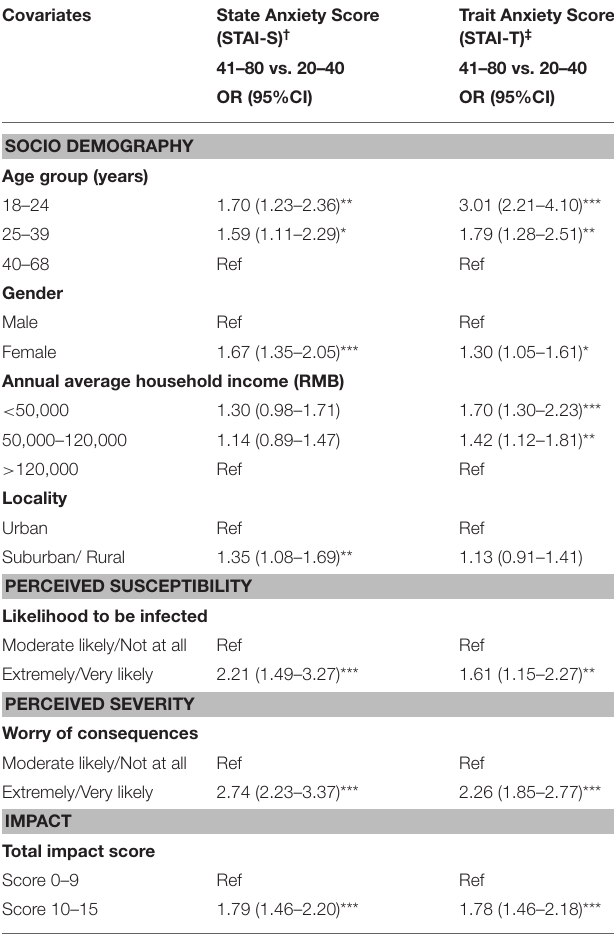
TABLE 2 | Multivariable logistic analyses of factors associated with total State-Trait Anxiety Score ( N = 2,446).